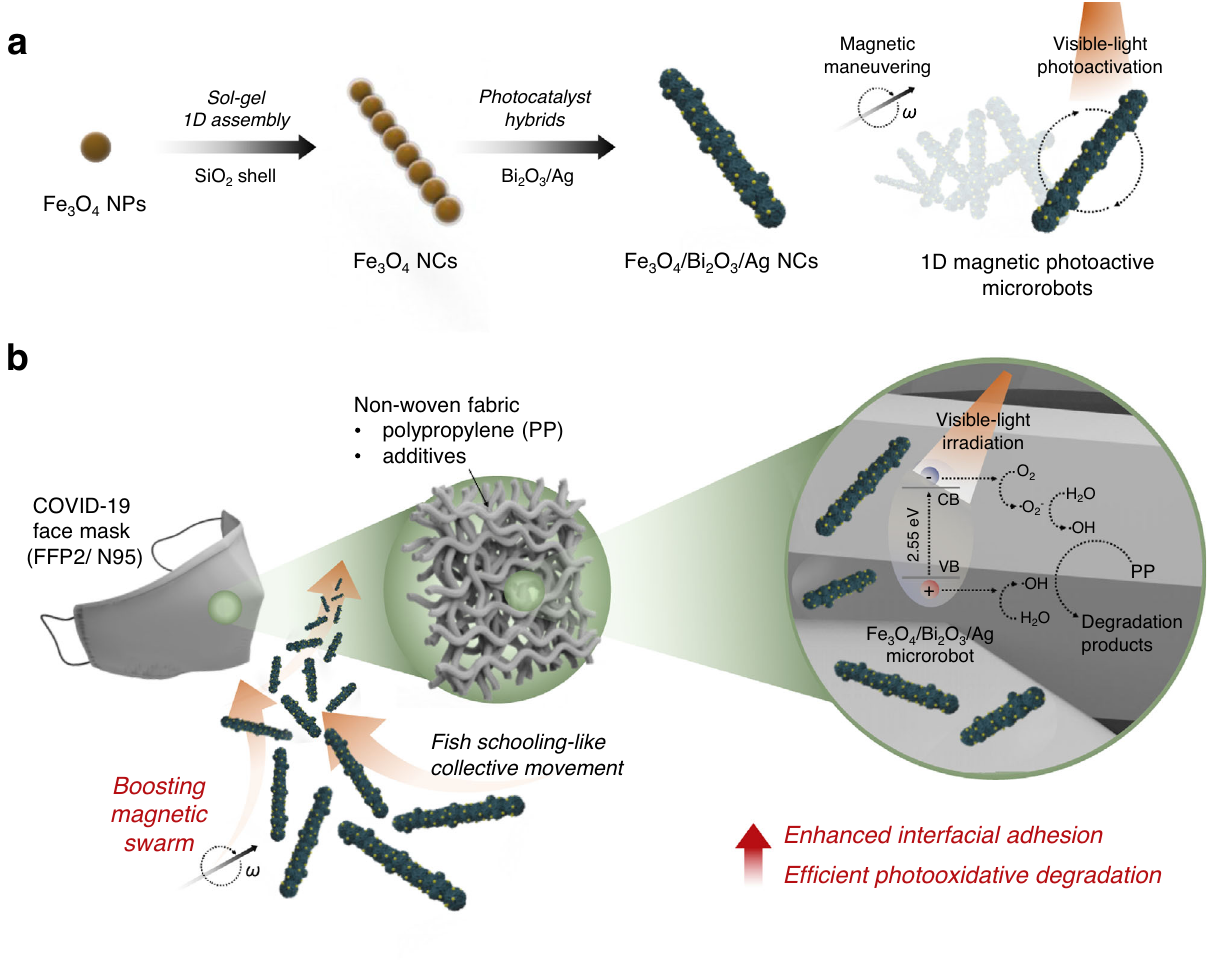
Fig. 1 | Schematic illustration of a magnetically boosted 1D photoactive microswarm for accelerated COVID-19 face mask disruption. a Fabrication of the hierarchicallyhybridized